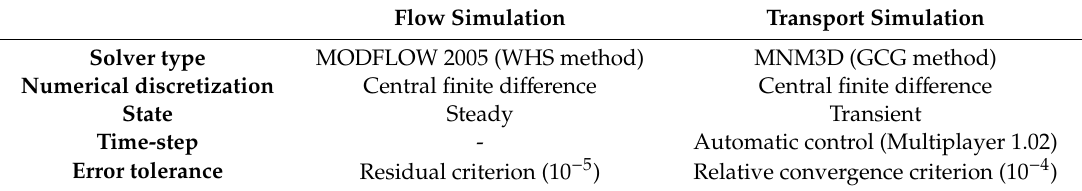
Figure 2. Model of aquifer realized in Micro and Nanoparticle transport Model in 3D geometrics (MNM3D) ( a ), model conceptualization along the transversal section A-A’ ( b ). Table 2. Flow and transport simulation